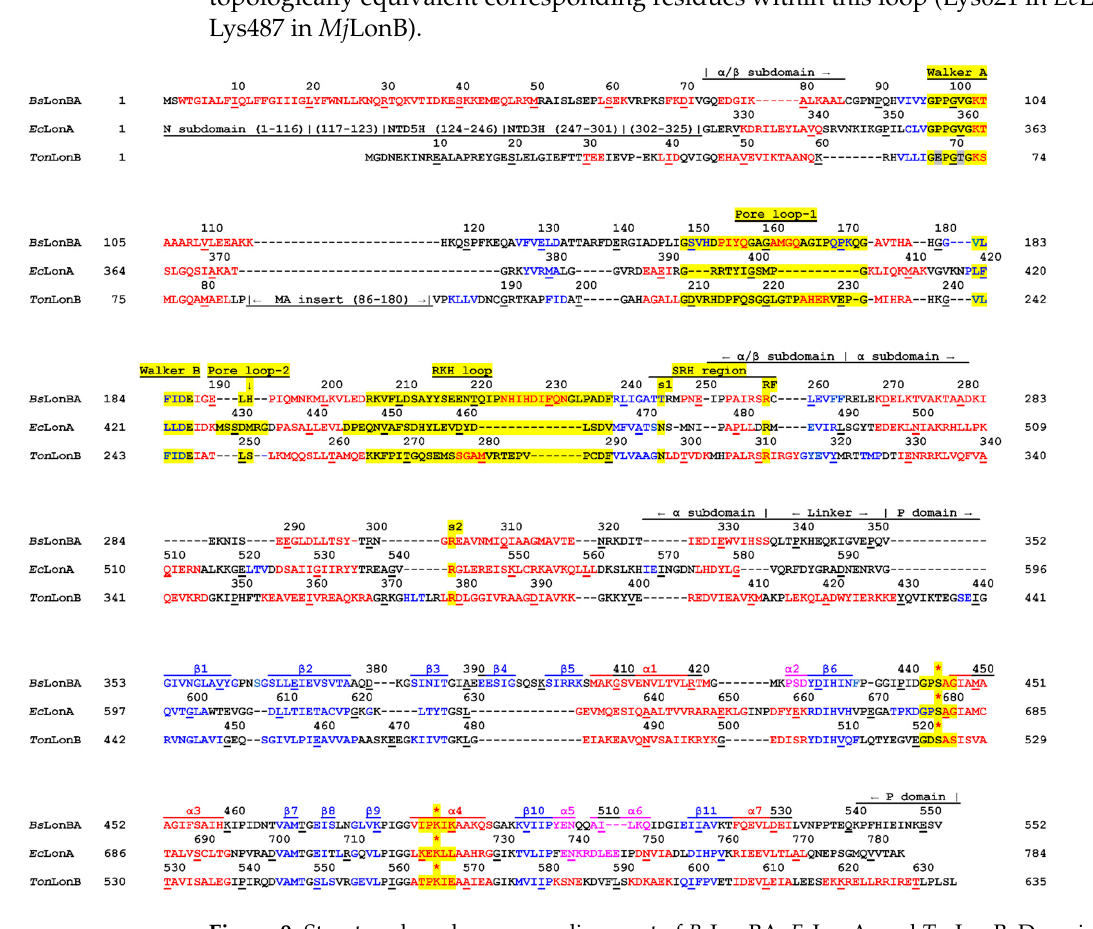
Figure 9. Structure-based sequence alignment of Bs LonBA, Ec LonA, and Ton LonB. Domain organization of Lon enzymes is shown. Red indicates amino acids that form α helices, magenta–3 10 helices, blue– β strands, and black color indicates amino acids that are not included in the regular secondary structure elements. Consensus sequence elements are highlighted in yellow: Walker motifs A and B, Pore loop-1, Pore loop-2, RKH loop, SRH region, the residues sensor-1 (s1), sensor-2 (s2), and arginine finger (RF), as well as fragments containing the catalytic serine (S*) and lysine (K*) residues. Four β strands ( β 1, β 2, and β 3, as well as β 6, positioned between β 2 and β 3 (Figure 3)), form in Bs LonBA a β -sheet that is also conserved in all Lon subfamilies. Unique among all subfamilies of Lon, only Mta LonC includes a helical twist after β 3. In turn, Bs LonBA is the sole exception that includes a protruding β -hairpin ( β 4– β 5) that forms a β -barrel in the